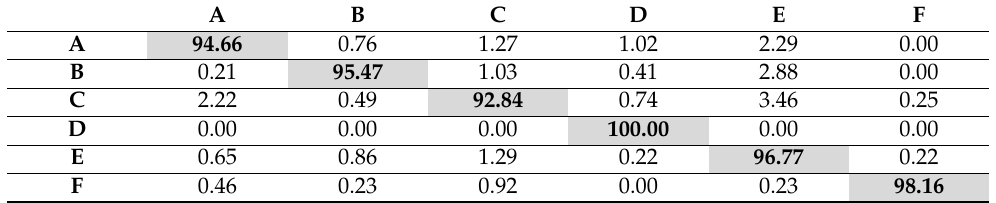
Table 7. Confusion matrix (%) of 3D-DIDGP28 on Set 1 using SVM classifier with RBF kernel